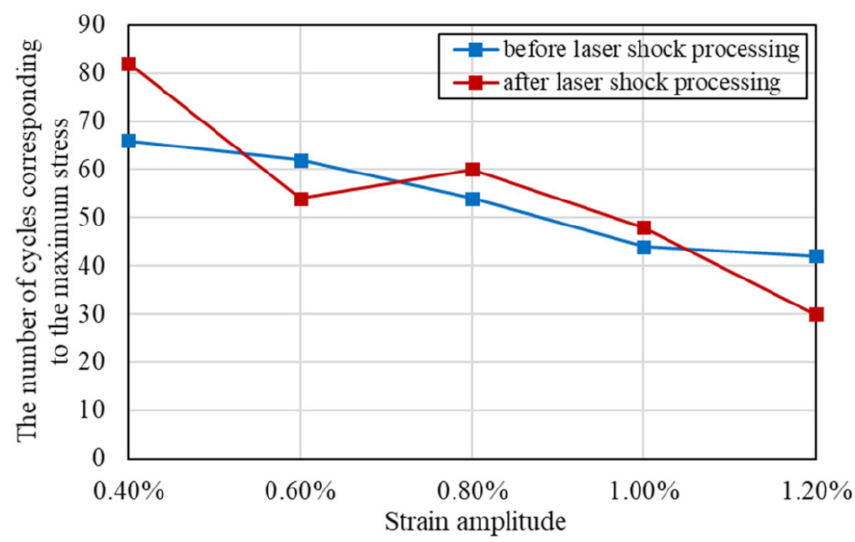
Figure 6. The number of cycles corresponding to the maximum stress at different strain amplitudes.